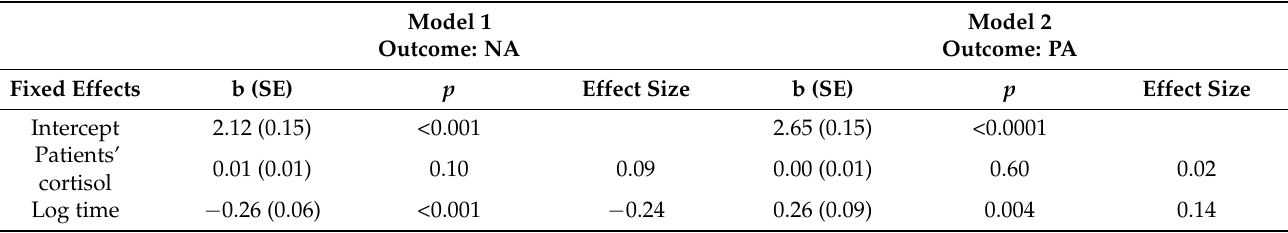
Table 2. Parameter estimates for patients’ cortisol change predicting negative affect (Model 1) and positive affect (Model